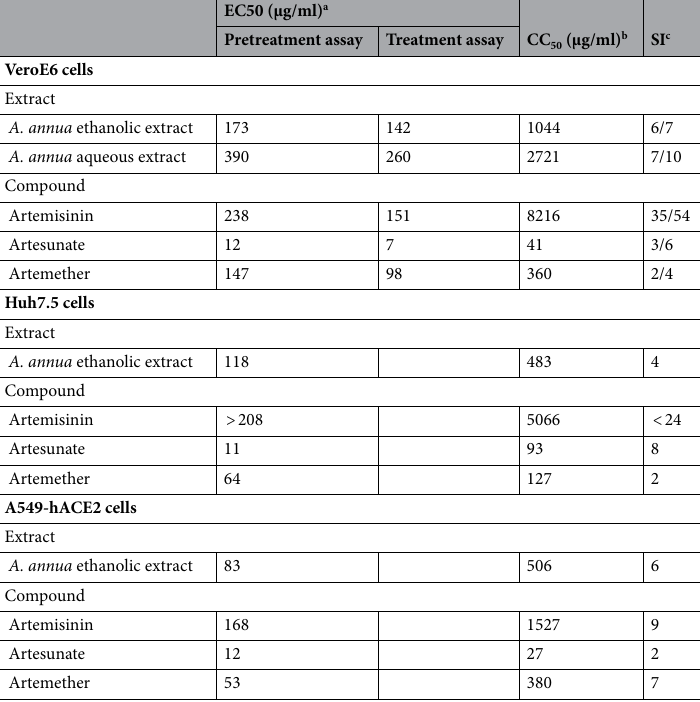
(pt) and 1009 µg/mL (t) (Figs. 2 and 3). The highest evaluated concentrations used in our assays were informed by the cytotoxicity of the extracts or compounds, as only concentrations resulting in cell viability greater than